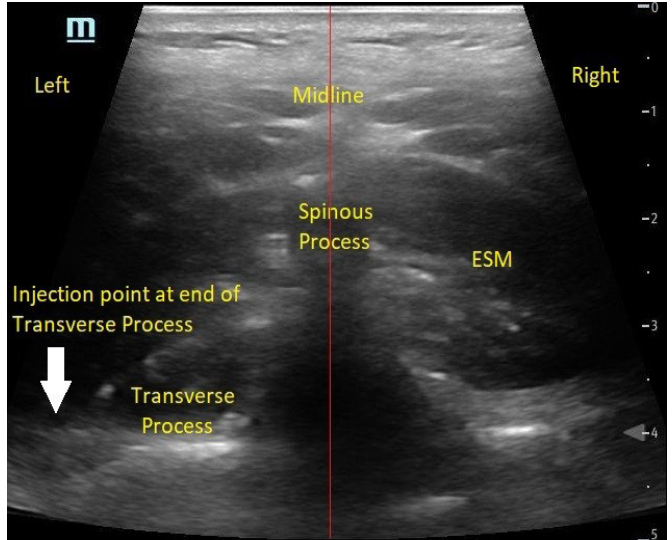
Image 3. Transversely oriented ultrasound view at the second thoracic (T2) vertebrae showing the spinous process, which indicates midline on the patient’s back. The erector spinae muscle (ESM) is visualized directly lateral to either side of the spinous process. The left transverse process is also visible as the hyperechoic linear structure deep and adjacent to the spinous process. The injection point for the erector spinae plane block is marked with the white arrow at the edge of the transverse process.